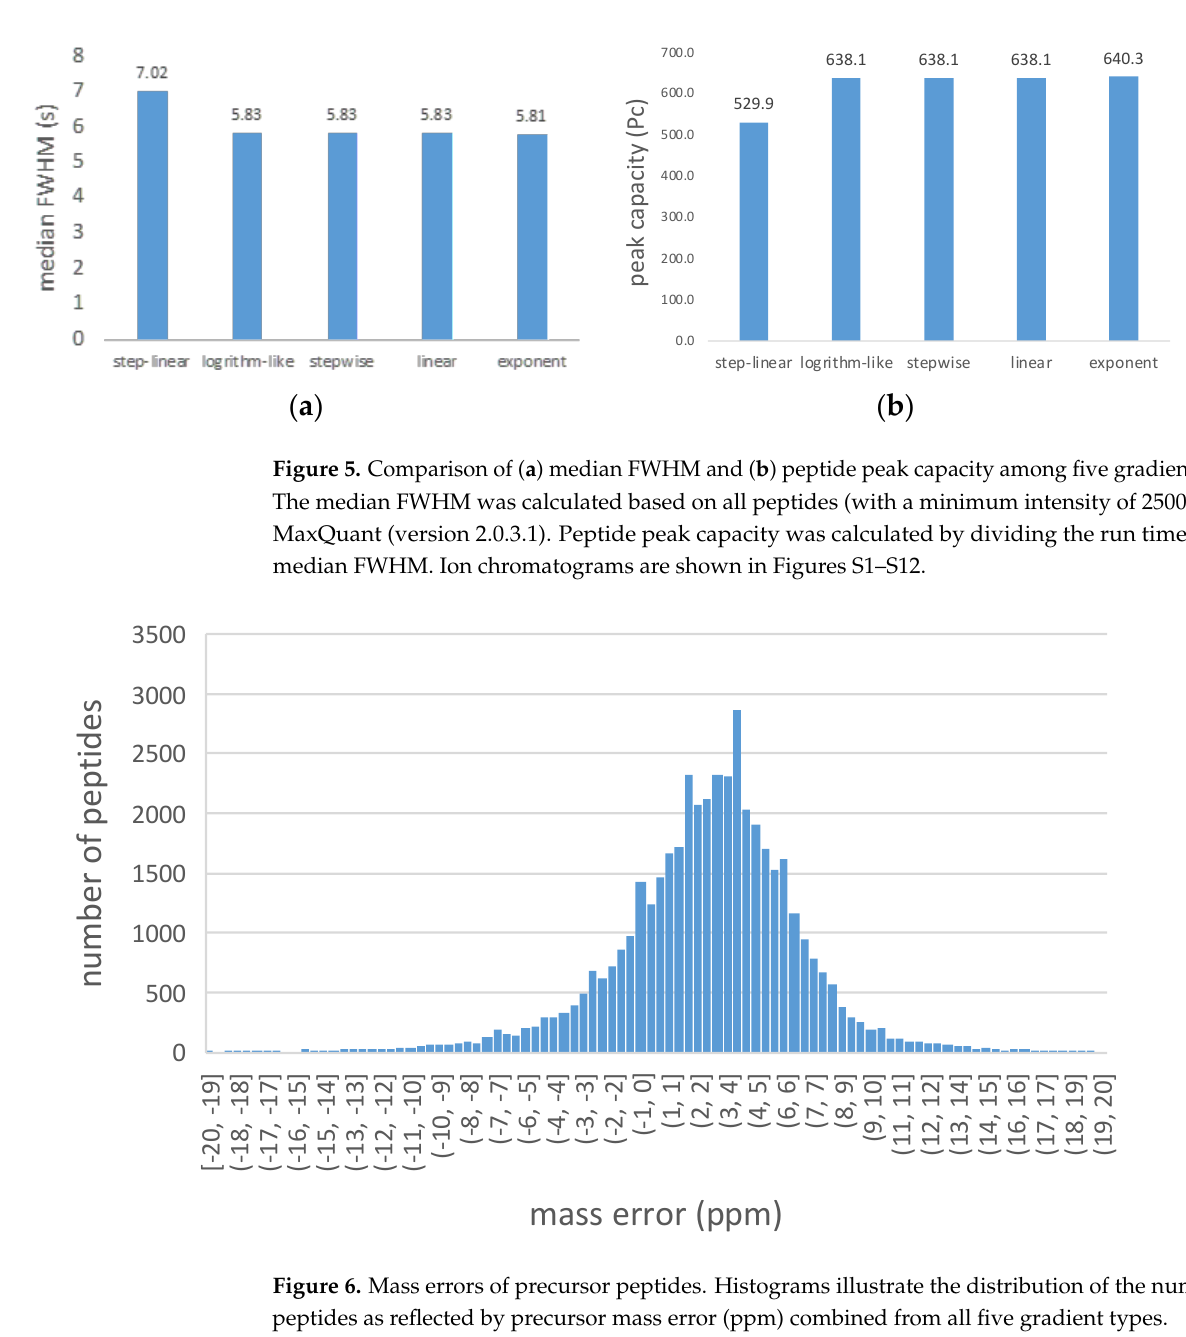
Figure 6. Mass errors of precursor peptides. Histograms illustrate the distribution of the number of peptides as reflected by precursor mass error (ppm) combined from all five gradient types.